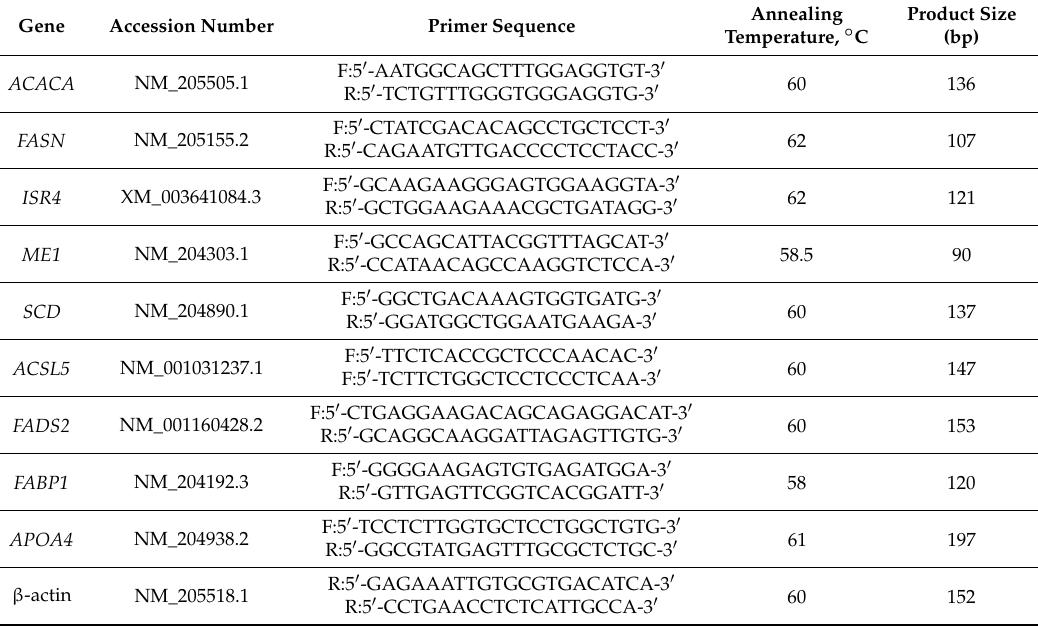
Table 3. Genes and related primers for quantitative real time PCR (qRT-PCR) analysis.